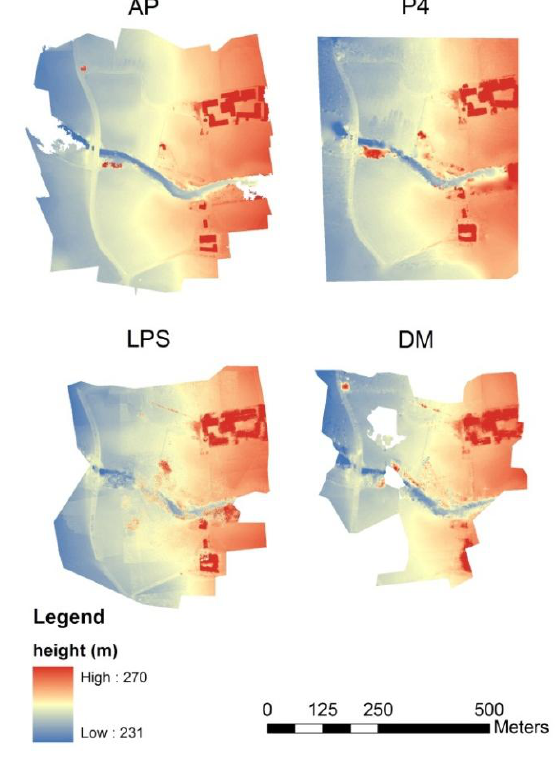
Figure 5 – DSM from AP, LPS, P4 and DM Figure 7 – Differences of DSMs: detail in a flat area In P4-AP comparison, the anomalous behavior visible in the red circle is due to the presence of trees' shadows (see Figure 8): the almost flat ground was modeled in one case with false height variations of the order of 1 m. This is probably due to homologous points chosen at shadows edges, which are slightly moving during the survey, thus causing mismatching and false intersections. This effect is visible also in the LPS and DM